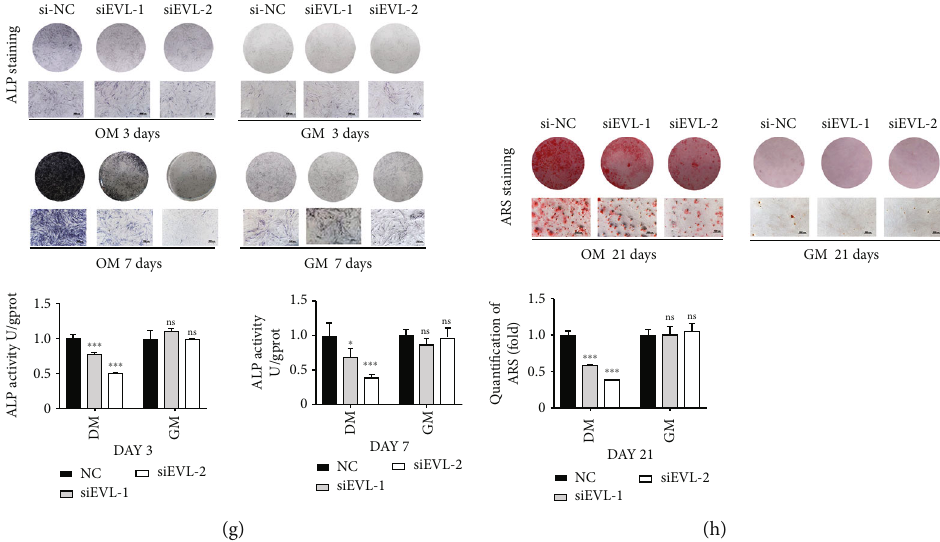
Figure 2: Knockdown of EVL inhibited the osteo-/odontogenic di ff erentiation of hDPSCs. (a, b) The expression of EVL during osteo-/ odontogenic di ff erentiation was con fi rmed with qRT-PCR and western blot. (c, d) The knockdown e ffi ciencies of siRNAs against EVL were veri fi ed by western blot assay and qRT-PCR. (e) The expressions of DSPP, DMP1, RUNX2, OCN, and OSX were analyzed in hDPSCs transfected with si-EVL and si-NC by western blot on the 7th day. (f) The expressions of DSPP, DMP1, ALP, RUNX2, OSX, OCN, and COL1A1 were analyzed in hDPSCs transfected with si-EVL and si-NC by qRT-PCR on the 3rd and 7th day. (g) ALP staining and quantitative intracellular ALP activity were measured in hDPSCs transfected with si-EVL and si-NC and cultured in growth medium (GM) or osteogenesis-inducing medium (OM) on the 3rd and 7th day. (h) Extracellular calcium deposition was visualized by alizarin red staining on the 21st day. Released dye in alizarin red staining was quanti fi ed by measuring absorbance at 562 nm. GAPDH was used as an internal control in qRT-PCR and western blot analyses. Data are shown as the mean ± SD ( n = 3 ); ∗ P ≤ 0 : 05 , ∗∗ P ≤ 0 : 01 , ∗∗∗ P ≤ 0 : 001